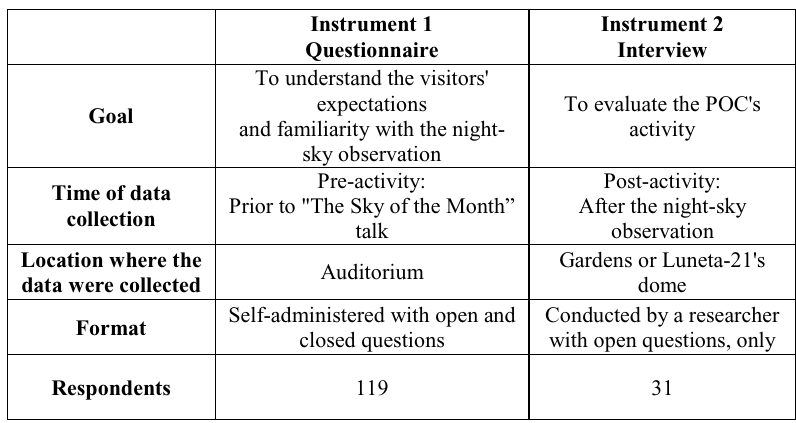
Table 1. Design of POC's